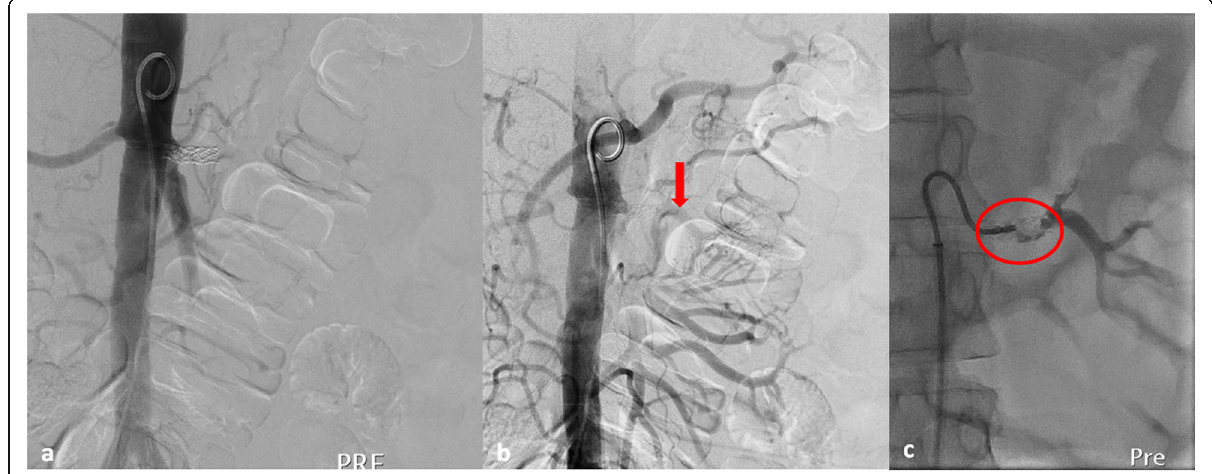
Fig. 1 a DSA at the level of the renal arteries demonstrating bilateral renal artery occlusion. b Delayed phase demonstrating perfusion of the distal renal artery (arrow) from collateral network. c Selective catheterization of the occluded stent and contrast infusion demonstrating in-stent thrombosis with characteristic contrast media feeling defects